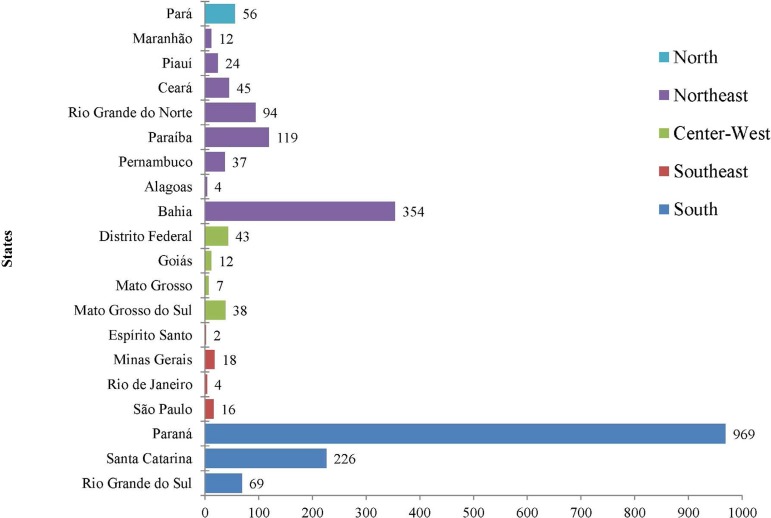
Distribution of retrieved hearts by State.